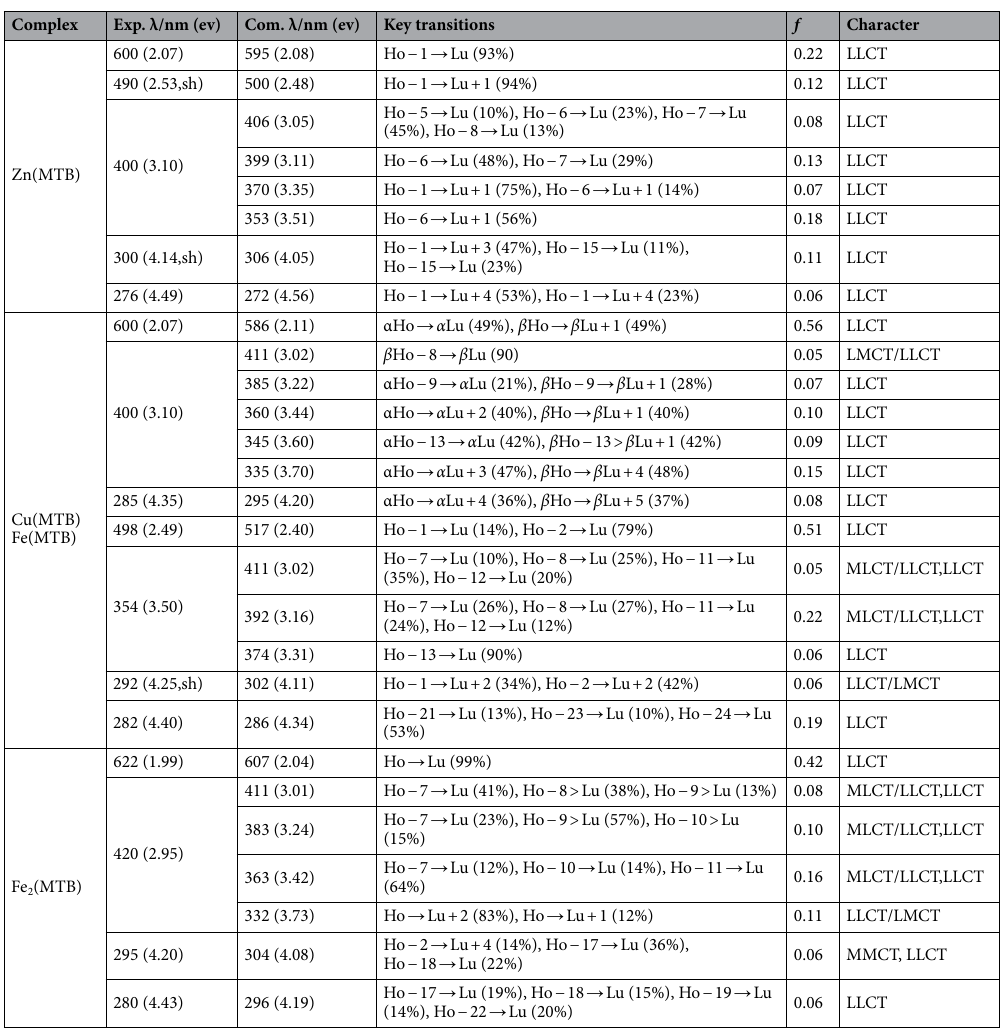
Table 5. Experimental and computed absorption wavelengths of Zn(MTB), Cu(MTB), Fe(MTB), and Fe 2 (MTB) complexes (the optimized structures of the complexes are shown in Fig. 6), and MO contributions (≥ %10) involved in each transition. Phrase LMCT stands for ligand-to-metal charge